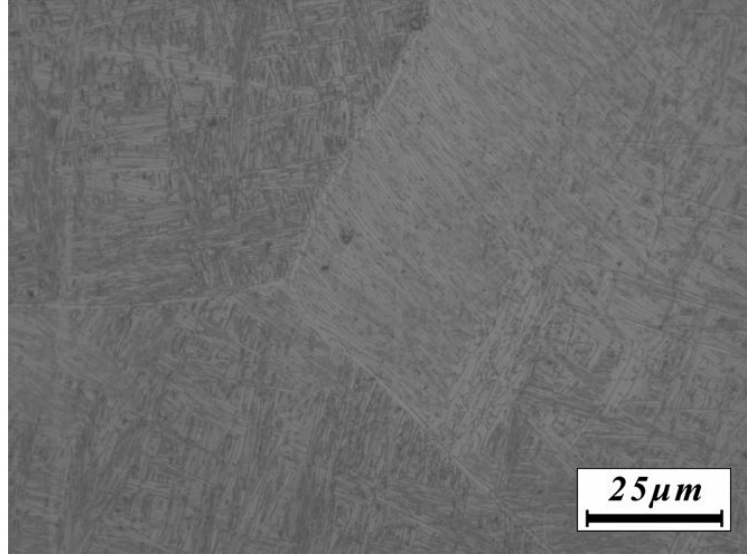
Figure 1. Original microstructure of the as-cast β 20C titanium alloy.